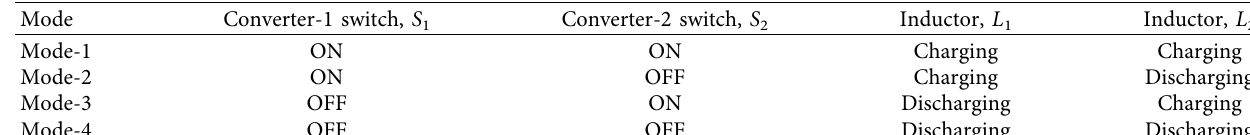
Table 3: DB converter modes of